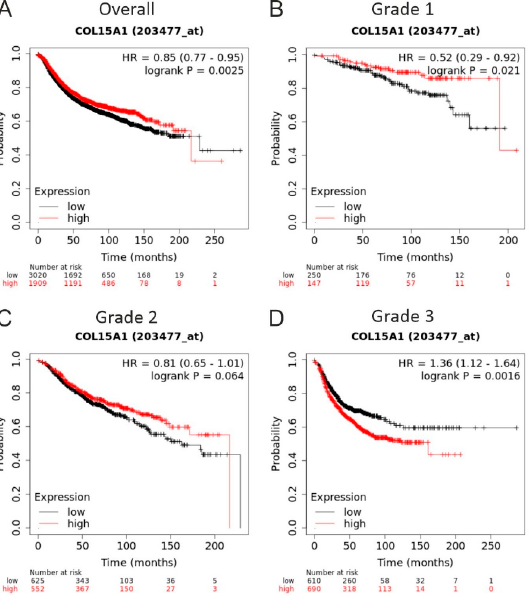
Figure 5. High ColXV mRNA expression is associated with good prognosis. Kaplan–Meir plots showing relapse-free survival of patients with breast cancer stratified by ColXV expression levels (probe: 203477_at). ( A ) All available breast cancer cases with ColXV expression data (N = 4929), ( B ) available grade 1 cases with ColXV expression data (N = 329), ( C ) available grade 2 cases with ColXV expression data (N = 1177) and ( D ) available grade 3 cases with ColXV expression data (N = 1300). For meta-analyses, the open access gene expression data and patients’ survival information from TCGA, GEO and EGA, compiled in a single database at ww.kmplot.com [31], were used. High ColXV, red line; low ColXV, black line. Hazard ratio (HR) and log-rank p values were automatically computed using the best performing threshold as the cut off. The number of patients for each analysis at different time points is also indicated in the survival graphs.